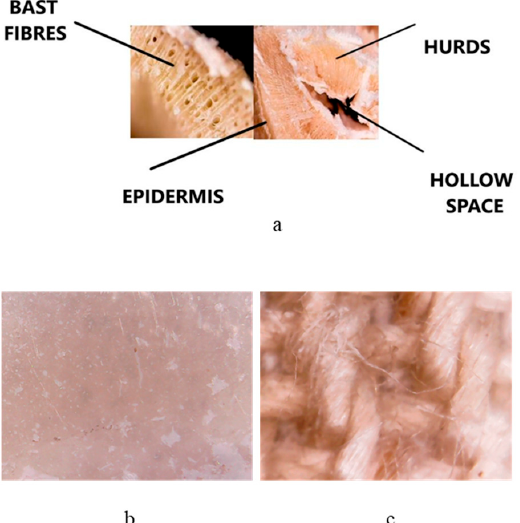
Figure 2. Images with an optical microscope of the HMP-STK cross-section ( a ), a thin film deposited on glass slab PLD-HMP-STK/Glass ( b ) and a thin film deposited on hemp fabric PLD-HMP- STK/HMP-FB ( c ).